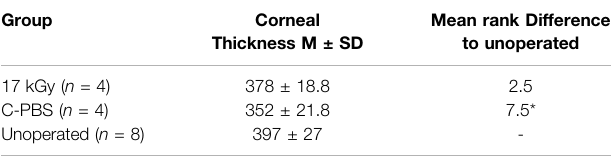
Statistical signi fi cance ( p ≤ 0.05) of operated eyes from healthy, unoperated control eyes was determined using a Kruskal-Wallis test (6.6, p = 0.03) with a Dunn ’ s multiple comparison between experimental and unoperated